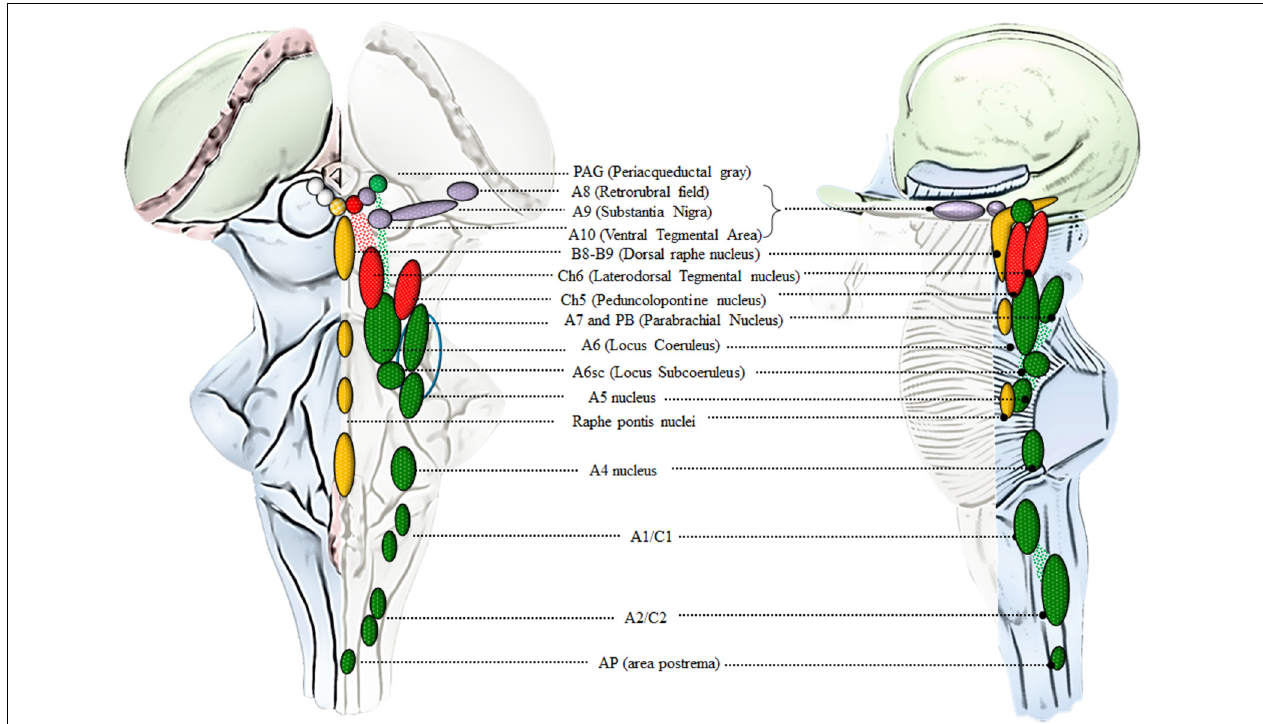
FIGURE 2 | An anatomical overview of the brainstem reticular formation (RF). This cartoon provides a synthetic overview of the neuroanatomy of brainstem RF nuclei in order to foster orientation within the brainstem when referring to the site-specificity of the effects induced by AMPHs. Monoamine-containing nuclei are placed in a quite restricted brain region corresponding to the median and lateral column of the brainstem RF. In detail, the median column hosts 5-HT-containing nuclei (yellow), which extend along the medulla and pons to reach the mesencephalon at the level of the periaqueductal gray (PAG). 5-HT containing nuclei at this level represent the rostral extent of the dorsal raphe nucleus (B8-B9). Since an analysis of 5-HT neurons in the effects of AMPHs is beyond the scope of the present review article, we focus on the dorsal raphe nucleus just concerning the PAG region, which contains catecholamine neurons. In fact, the PAG hosts a mixed population of catecholamine and acetylcholine (ACh)-containing nuclei which are placed in the lateral column of the RF. This is the case of DA (violet), NE (green) and ACh (red) nuclei which represent the rostral extent of A10 Ventral Tegmental Area (VTA), A6 (LC) and CH6, respectively. Moving downstream to the mesencephalic DA nuclei (A8, A9, A10), a constellation of nuclei appears within the lateral column of RF. These include the two pontine ACh nuclei (Ch5 and Ch6) and a number of NE nuclei placed along the ponto-medullary RF, namely A6 (LC), A6sc (subcoeruleus), A7 which intermingles with NE neurons of the rostral PB nucleus (here represented as a continuum), A5, A4, and two mixed NE/E-containing groups in the medulla, namely A1/C1 [rostral ventrolateral medulla (RVLM)] and A2/C2 (dorsomedial cell group), which extends towards the obex within the AP (area postrema). The A7 neurons together with PB-NE neurons and the A5 nucleus contribute to define the Kolliker-Fuse nucleus (blue circle, Milner et al., 1986; Byrum and Guyenet, 1987). The A6 nucleus together with the A6sc, the medial PB in the rostral pons and the epicoeruleus nucleus within the PAG, constitute the LC